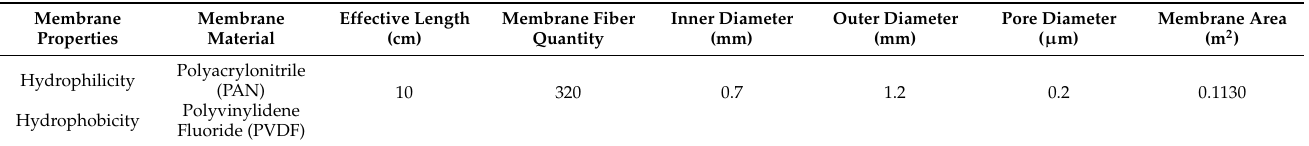
Figure 1. Schematic diagram of the MBR. Table 1. Properties of membrane modules tested.